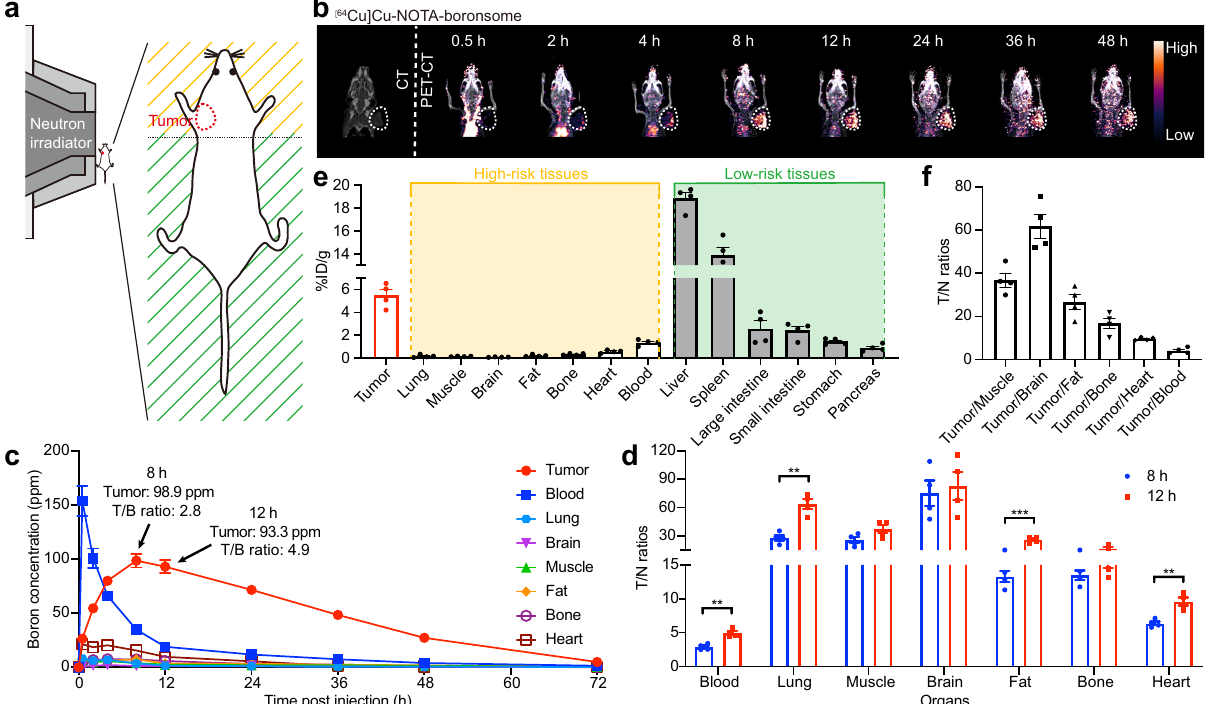
Fig. 4 PET imaging indicated that boronsome showed high accumulation in tumour but low uptake in other high-risk tissues. a Schematic representation of a mouse located at the beam terminal of the neutron irradiator. Tissues within radiation radius are marked as high-risk tissues (yellow). Tissues outside the radiation radius are marked as low-risk tissues (green). b Representative CT and PET-CT images of the female BALB/c mouse at various time points depicting [ 64 Cu]Cu-NOTA-boronsome uptake. Tumours were circled with white dashed lines. c Time-dependent boron concentration in tumour, blood, lung, brain, muscle, fat, bone and heart post injection of boronsome (500 mg/kg, i.v.) measured by ICP-OES ( n = 4). d Tumour-to-normal tissue ratios (T/N ratios) of organs 8 and 12 hours post once injection of boronsome (500 mg/kg, i.v., n = 4). Two-tailed unpaired Student ’ s t test, blood: ** p = 0.0015, lung: ** p = 0.0012, fat: *** p = 0.0003, heart: ** p = 0.0026. e Corresponding biodistribution ( n = 4) of [ 64 Cu]Cu-NOTA-boronsome in 4T1 bearing mice 12 h post injection. f Tumour-to normal tissues ratios (T/N) ( n = 4) by biodistribution at 12 h. Data are means ± SEM. Source data are provided as a Source Data fi